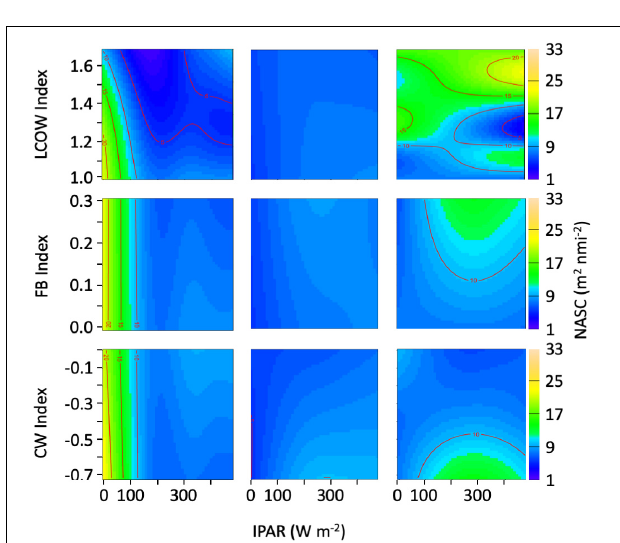
FIGURE 6 | Heatmap representing acoustic backscatter (NASC) as a function of the oceanographic index and light intensity ( IPAR 5 m ). (Left panels) Represent the epipelagic (15–200 m), (center panels) represent upper-mesopelagic (200–600 m), and (right panels) represent lower mesopelagic (600–1000